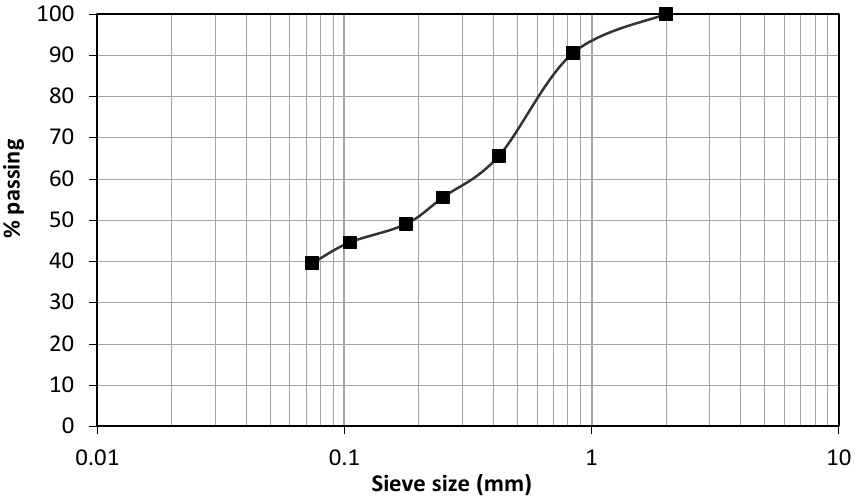
Figure 3. Particle size distribution of soil.